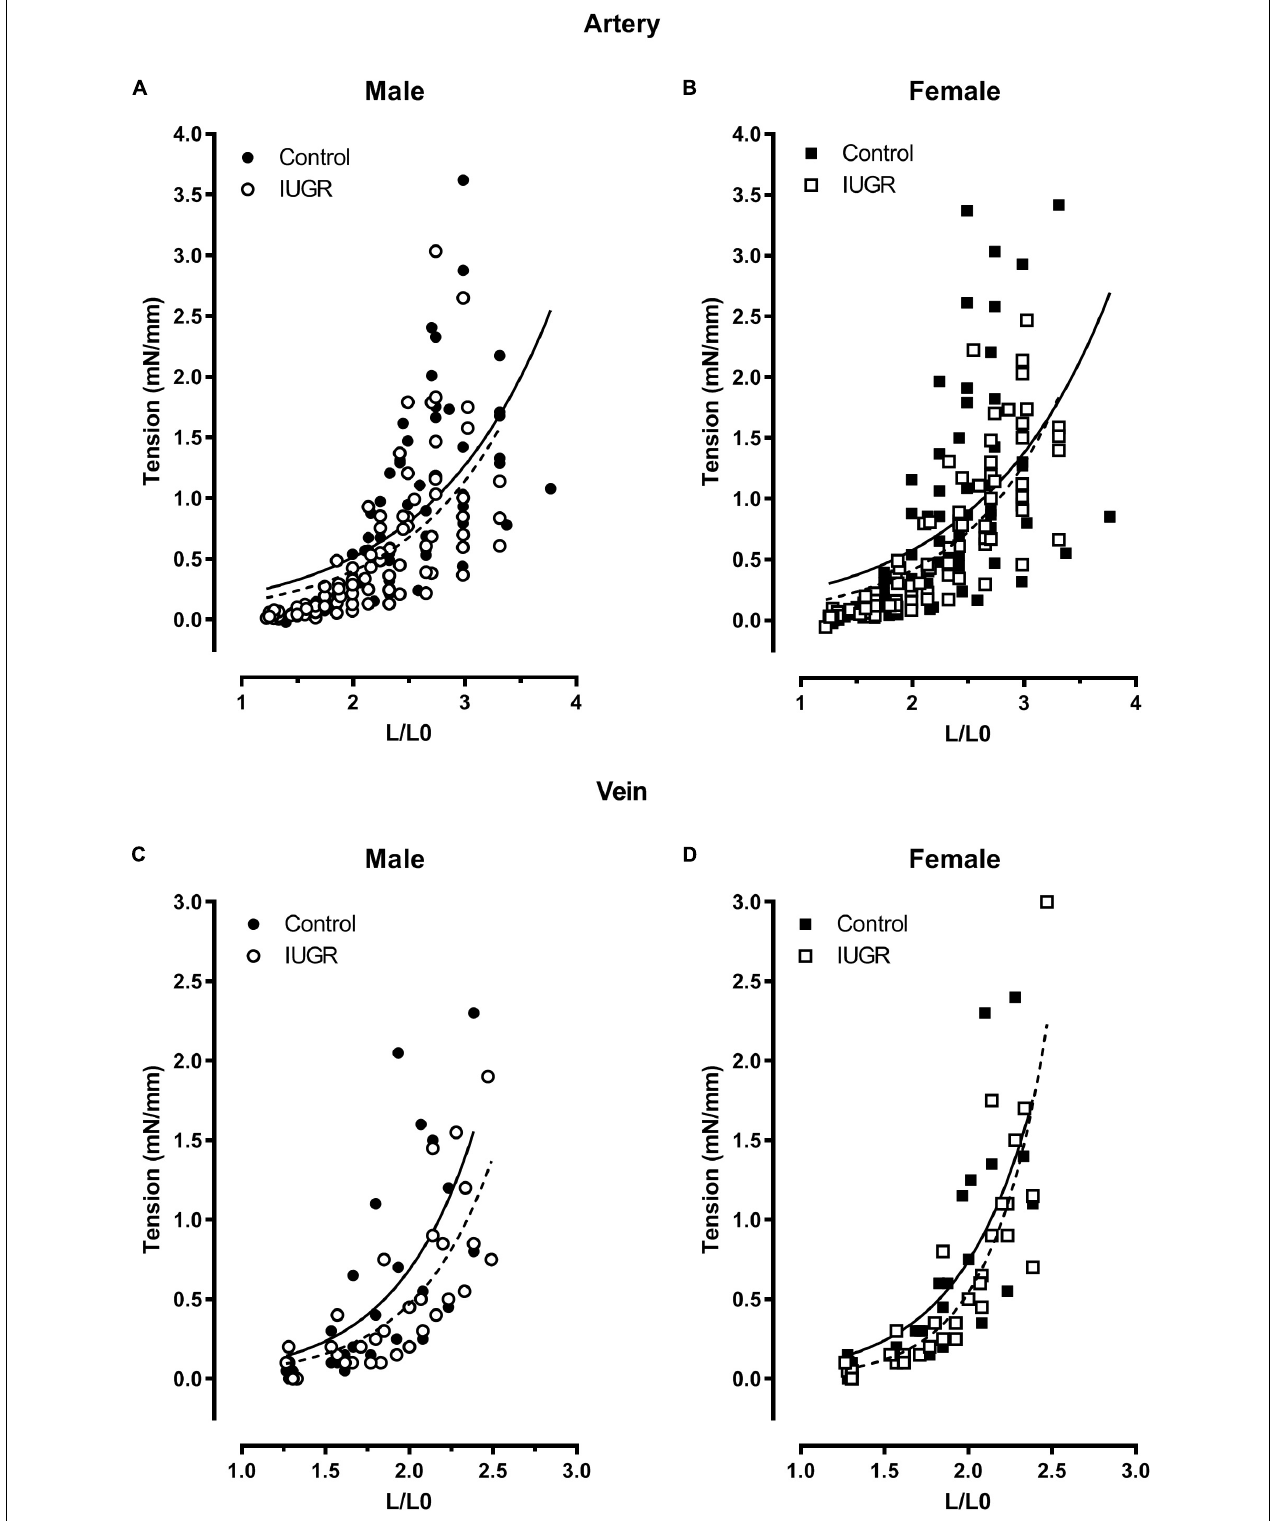
FIGURE 6 | Length-tension relationship in the umbilical artery ( A,B , control n = 14, IUGR n = 13) and vein ( C,D , n = 5, each group). The lines are the best fit of all experimental points (solid: control; dotted: IUGR).